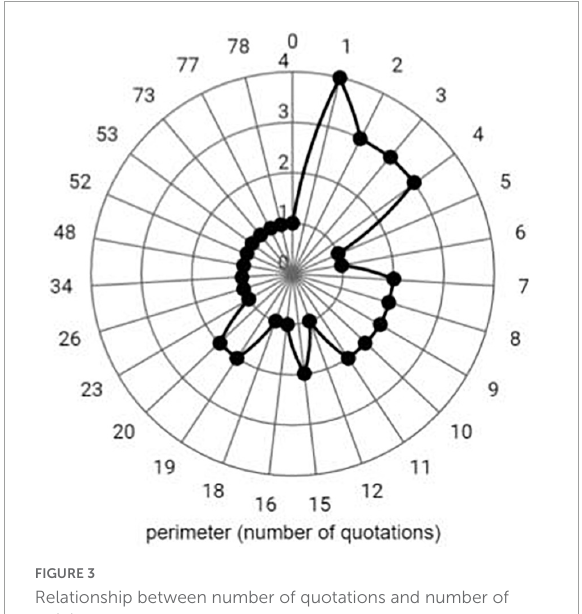
FIGURE3 Relationship between number of quotations and number of